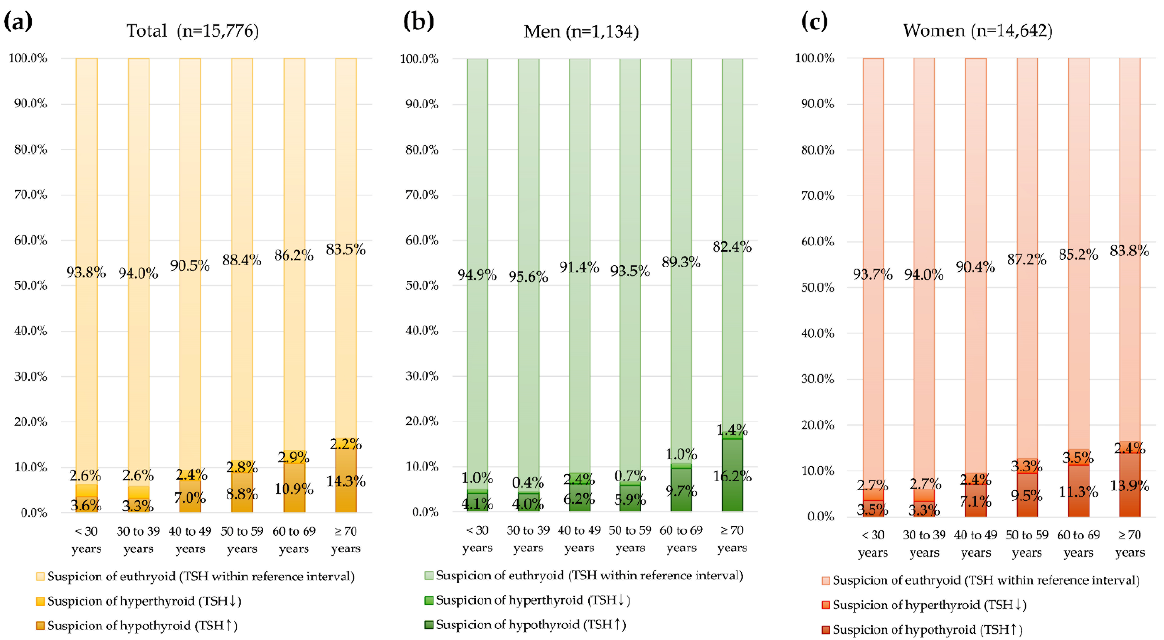
Figure 3. Specimen thyroid function test (TFT) results among 15,776 specimens with only one measure of TSH test by age group. ( a ) For total subjects, ( b ) men, and ( c ) women. For 20,469 specimens with all three TFTs, the proportion of euthyroid decreased with an increasing age (Figure 4). The proportion of euthyroid was the highest in men aged 50–59 years, which was the predominant age group among men. The prevalence of specimens with “more clinical information needed” was higher in men (5.6%) than in women (3.6%).